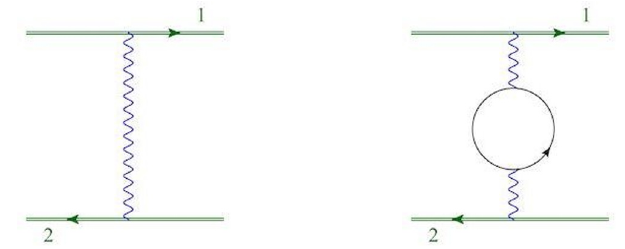
Figure 1. Two low-order examples of webs with two Wilson lines in an abelian gauge theory.